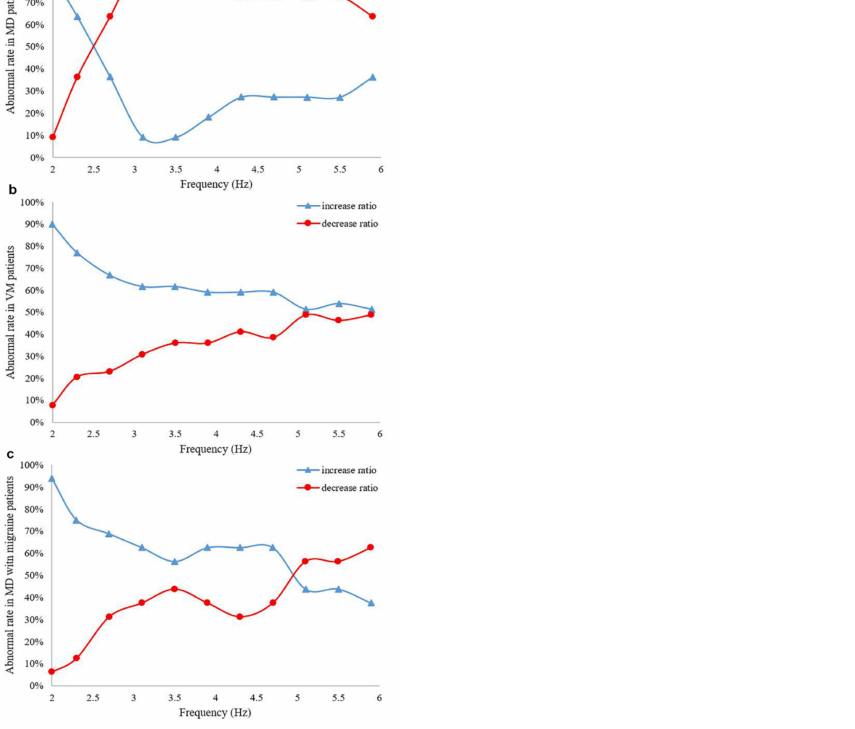
Figure 2. The proportion of the horizontal gain decrease in MD, VM and MD with migraine patients. ( a,b ) blue line, MD patients; light red line, VM patients; in most MD patients, the horizontal gain decreased in the range of 3–4 Hz, while in most of the VM patients, horizontal gain increased between the range of 2–3 Hz. MD, Meni è re’s disease; VM, vestibular migraine. ( c ) Blue line, MD with migraine patient’s horizontal gain increase ratio; light red line, MD with migraine patient’s horizontal gain decrease ratio. More MD with migraine patients had an increased horizontal gain when the frequency was less than 5.0 Hz and had a decreased horizontal gain when the frequency was greater than 5.0